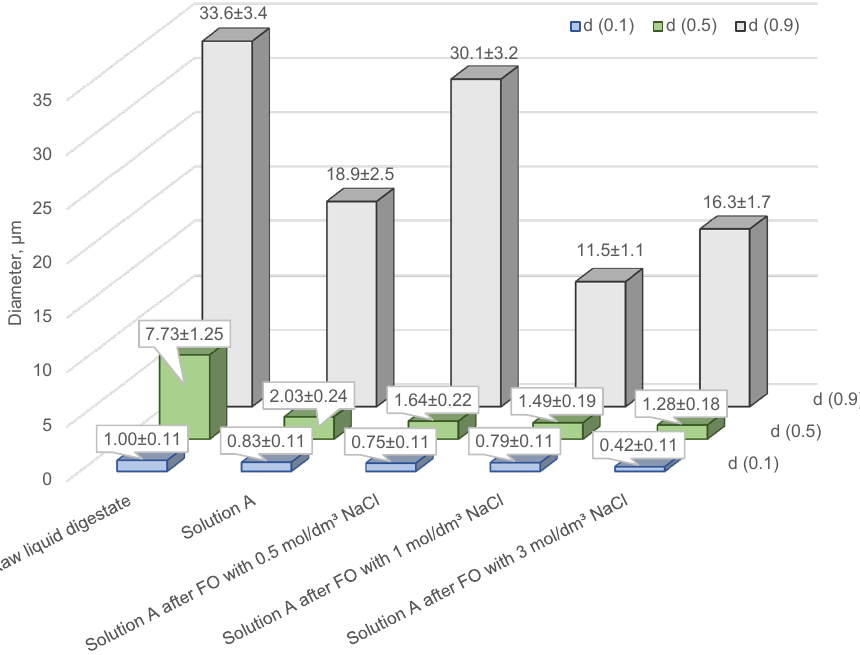
Figure 11. Particle size distribution for the liquid raw digestate, solution A (digestate after struvite precipitation) and the feed solution (solution A after FO).